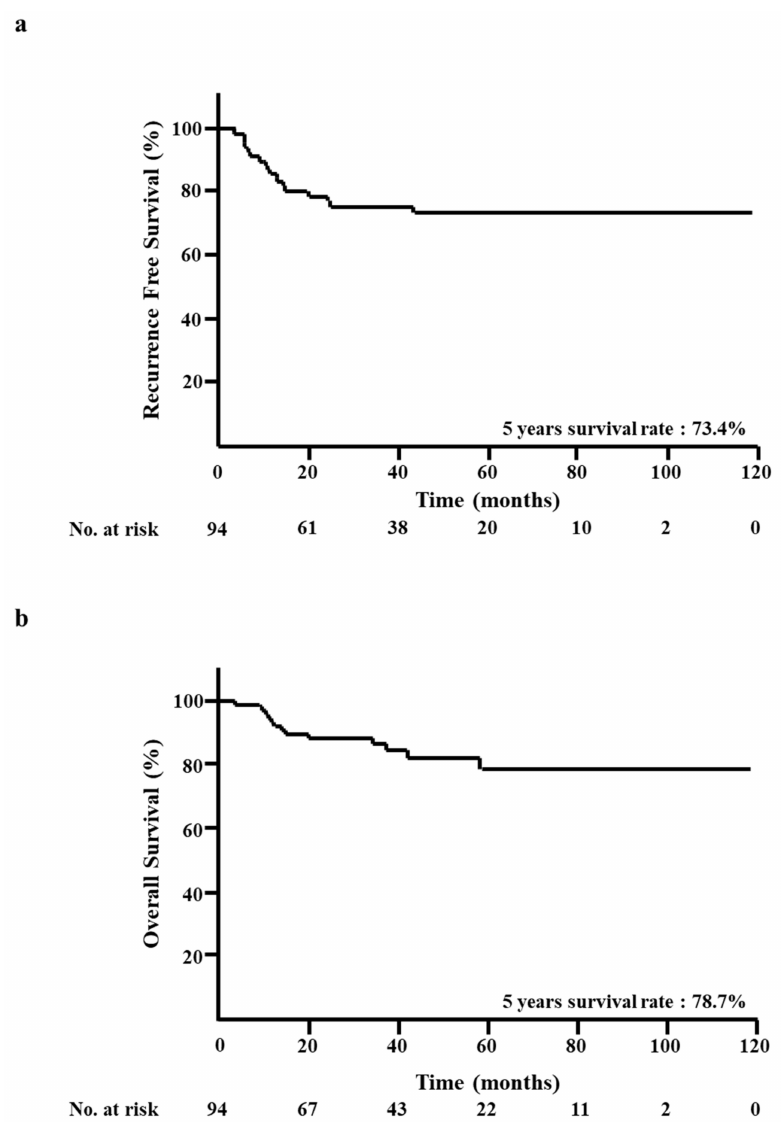
Figure 1. Kaplan–Meier analysis of all patients. ( a ) Recurrence-free survival (RFS). ( b ) Overall survival